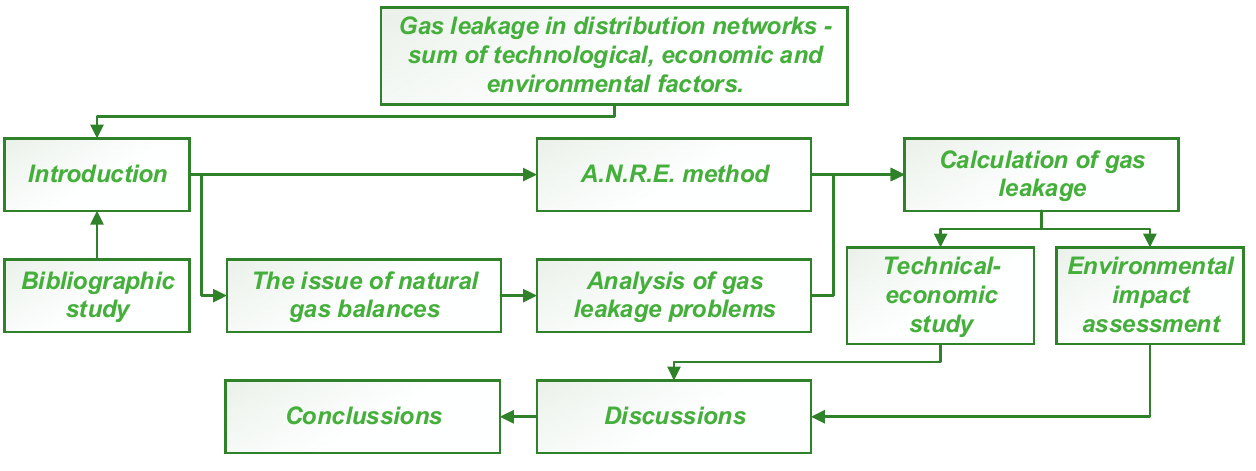
Figure 2. Graphical abstract (source: authors based on research data).